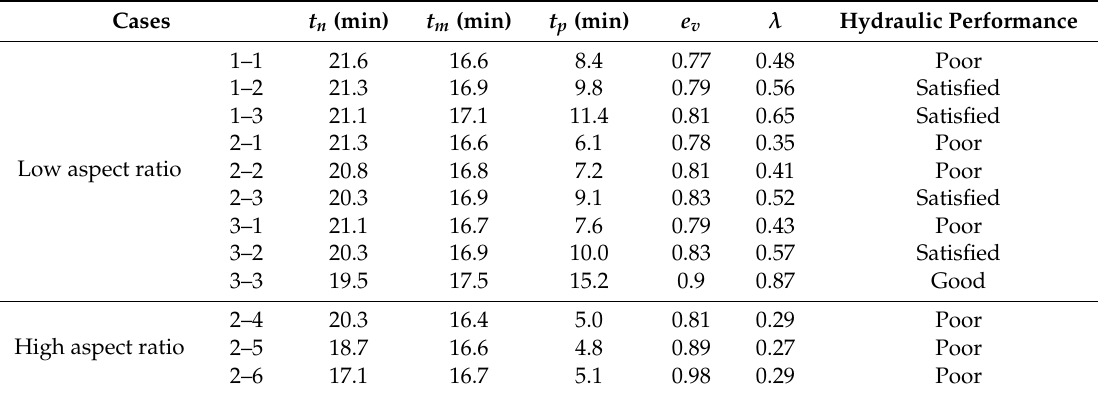
Table 3. Nominal retention time, mean residence time, peak time, effective volume, and hydraulic efficiency of cases with emergent